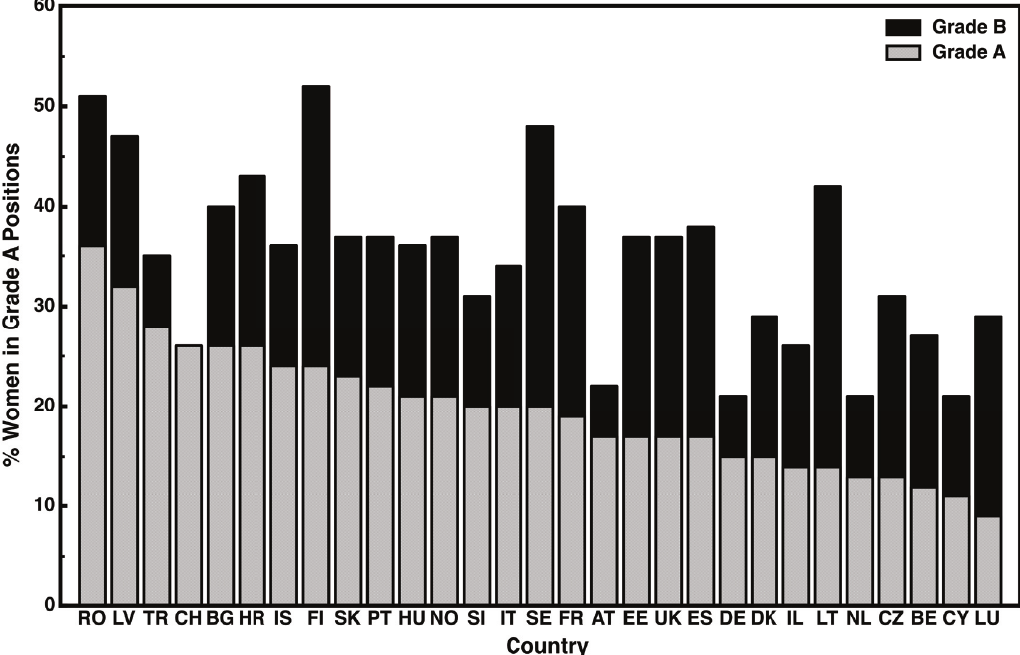
Figure 1. Proportion of female academic staff in Grade A and B positions in Europe in 2010 (for definitions of grades see main text). Data obtained from the 2012 European Commission She figures for gender in research and innovation 11 . For description of the source data see ref.